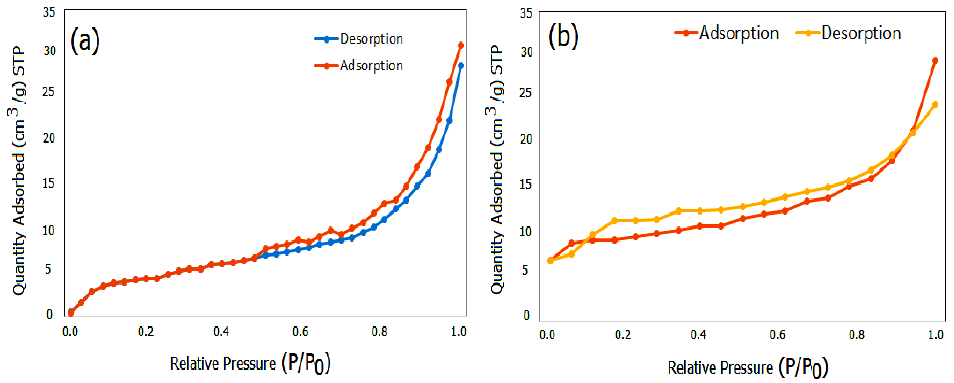
Figure 9. BET surface area analysis of ( a ) palladium nanoparticles, ( b ) Pd − Chit@MnFe 2 O 4 .